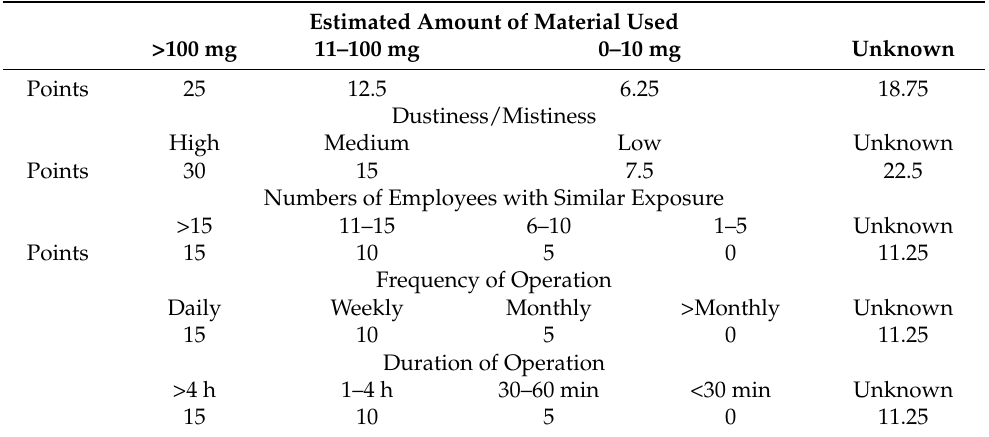
Table 4. Probability scores.